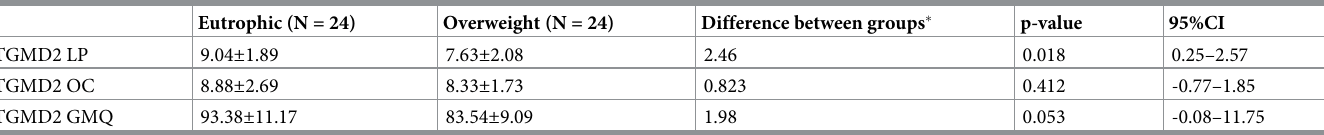
Table 2. Comparison between groups for motor